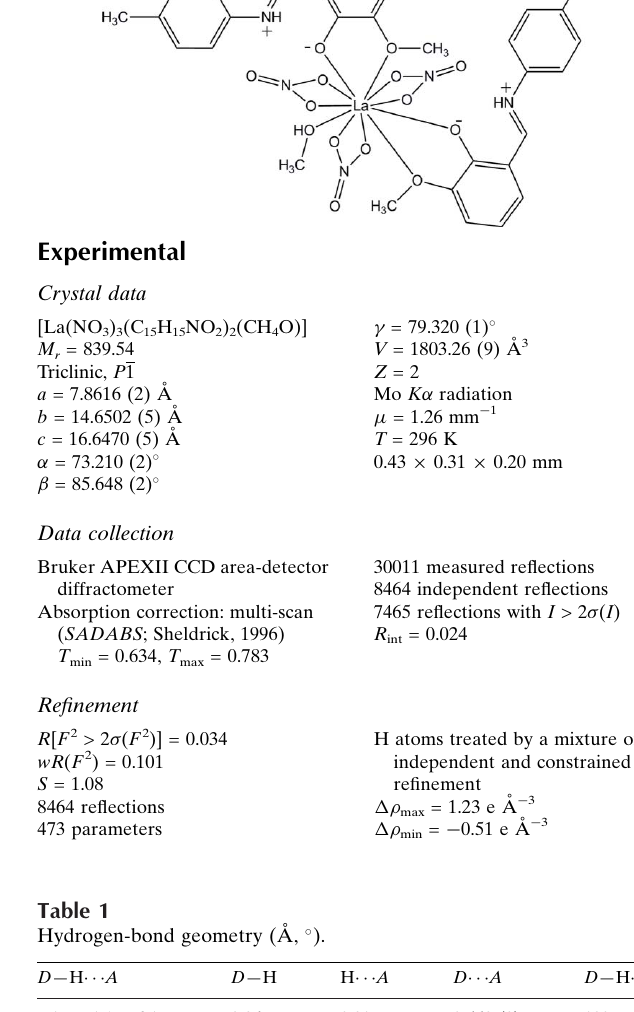
structure: SHELXL97 (Sheldrick, 2008); molecular graphics: SHELXTL (Sheldrick, 2008); software used to prepare material for publication: SHELXTL